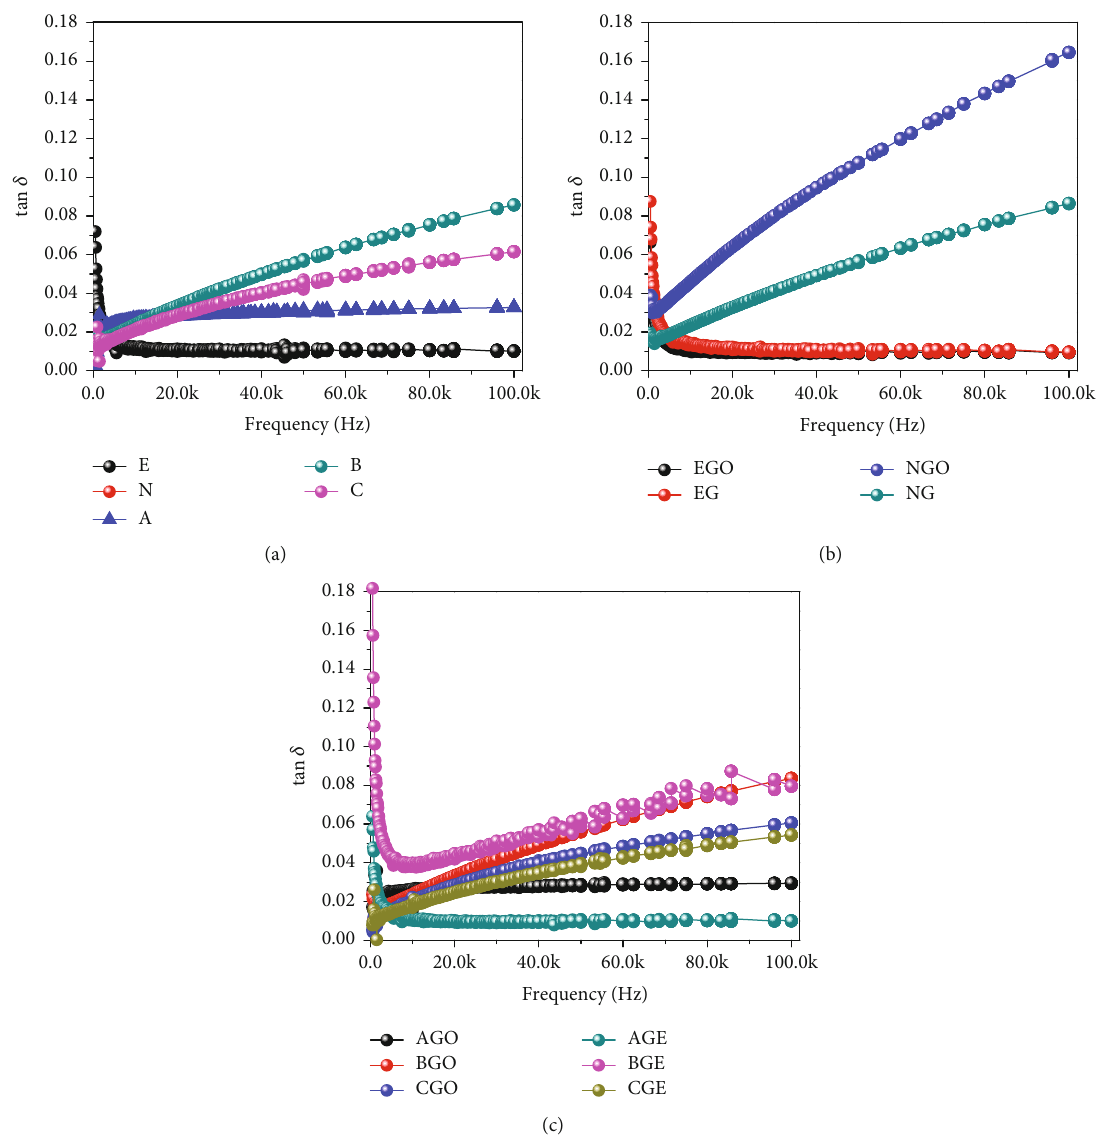
Figure 10: Loss factor of (a) un fi lled single and double matrix, (b) single matrix- fi lled GO and G, and (c) double matrix- fi lled GO and